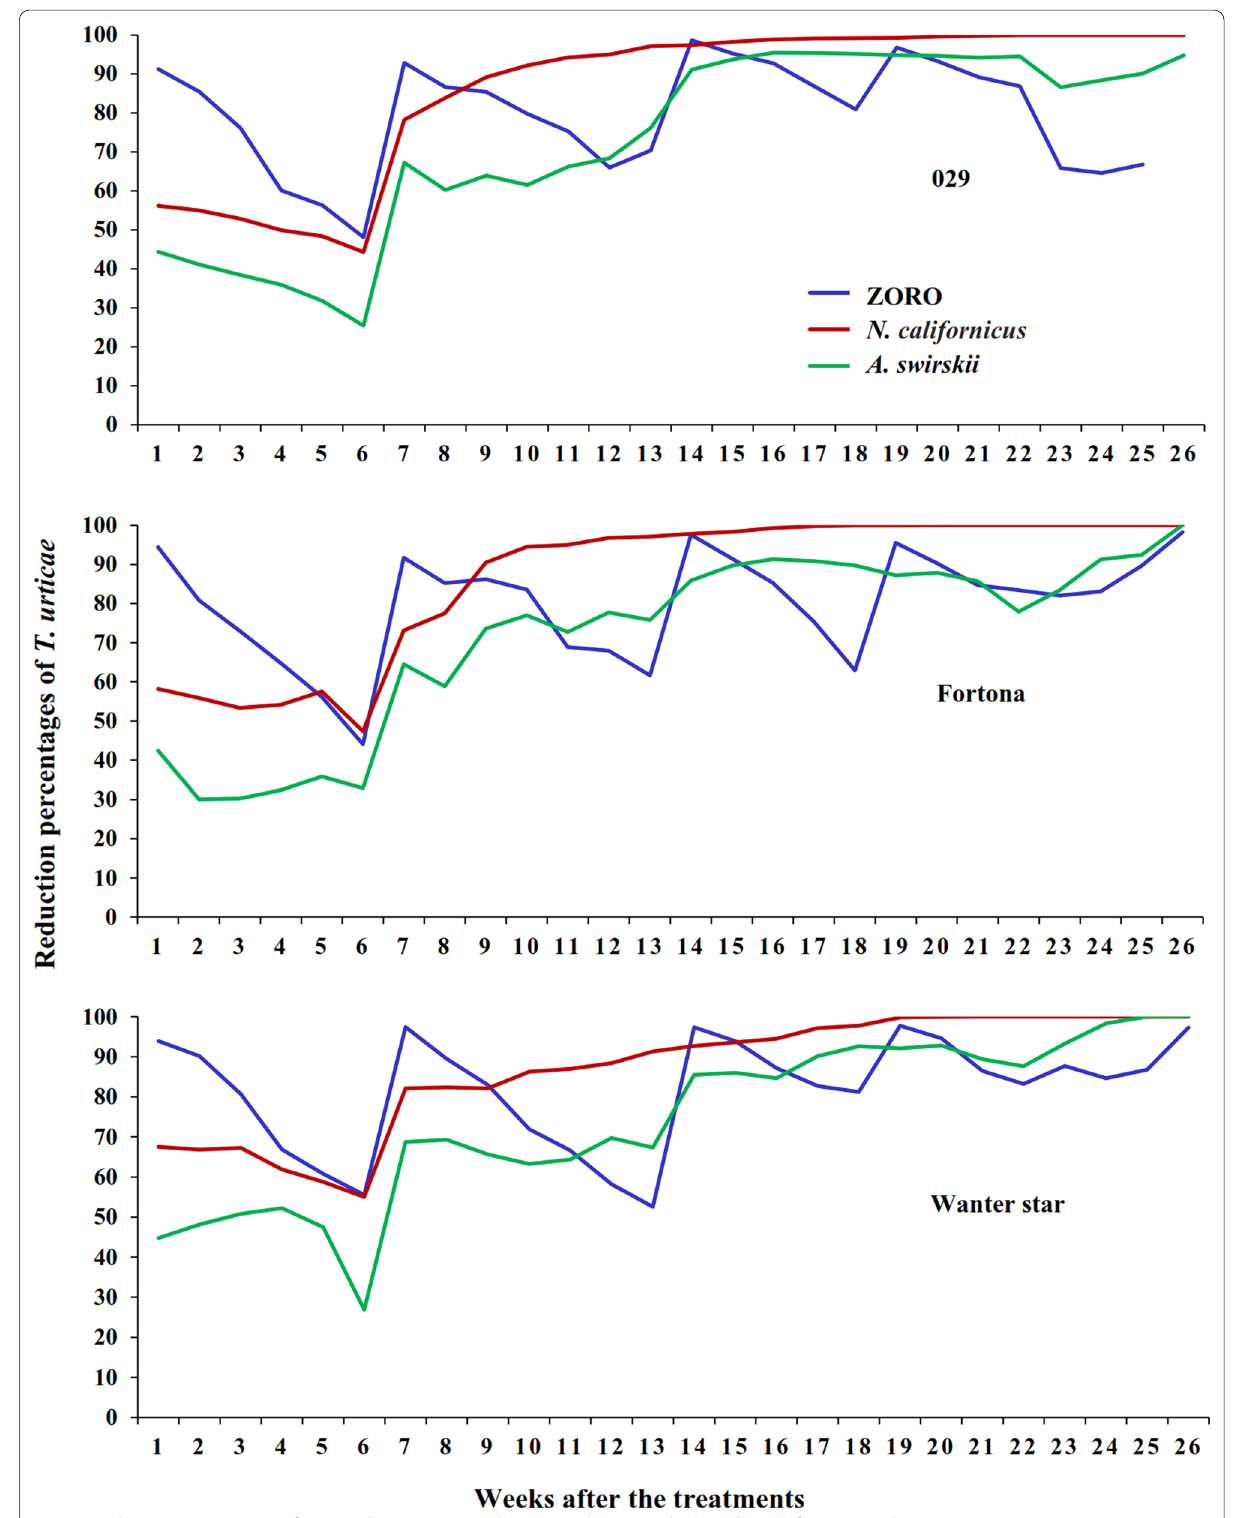
Fig. 2 Reduction percentages of Tetranychus urticae populations on three strawberry cultivars after Tetranychus urticae management treatments. The treatments were: Neoseiulus californicus , Amblyseius swirskii release and ZORO